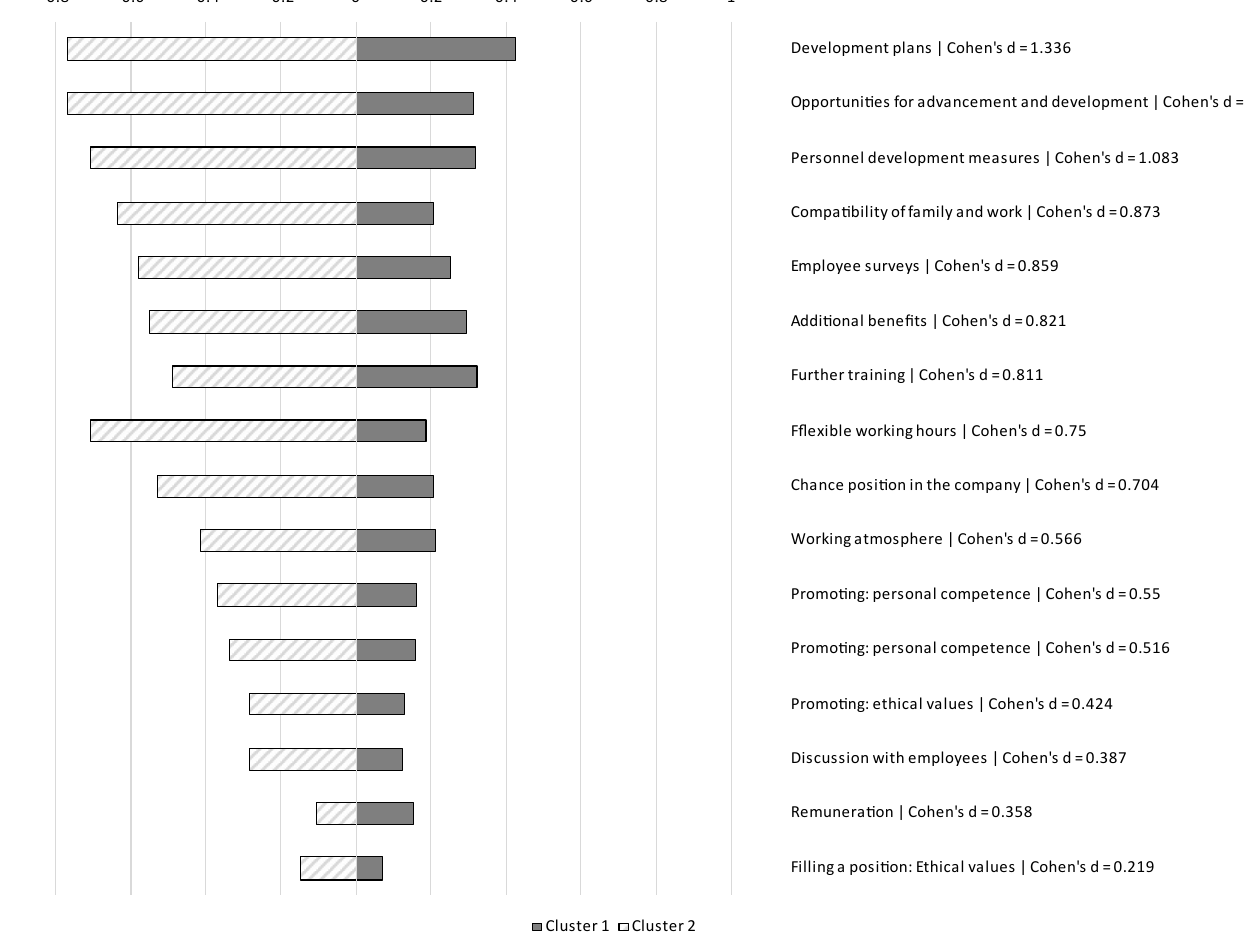
Table 1. Description of the study population according to the clusters.